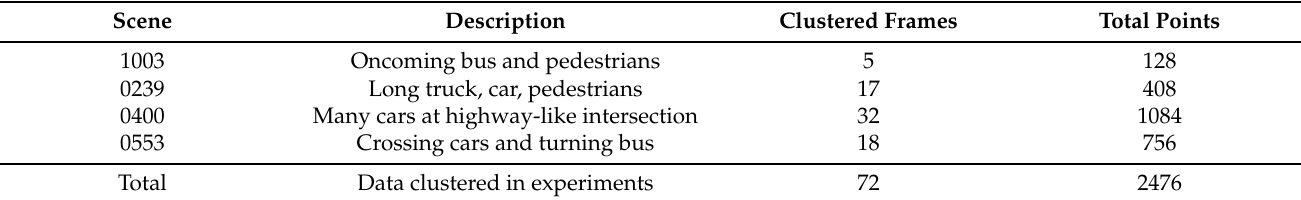
Table 1. Overview of filtered data sets used for